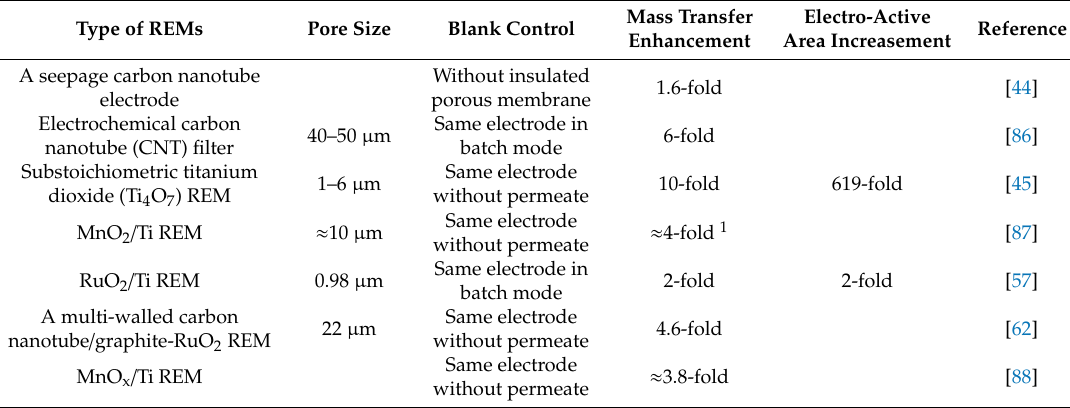
Table 1. Several representative types of reactive electrochemical membrane